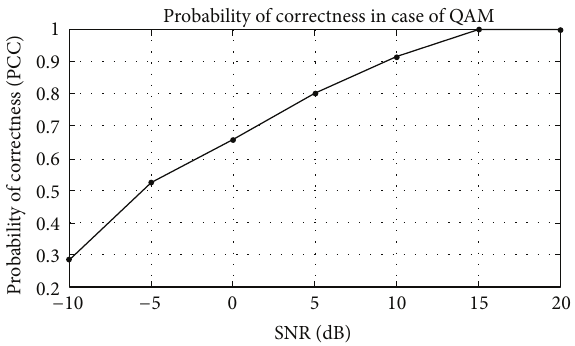
Figure 15: Probability of correctness (PCC) versus SNR for fixed number of iterations in QAM32